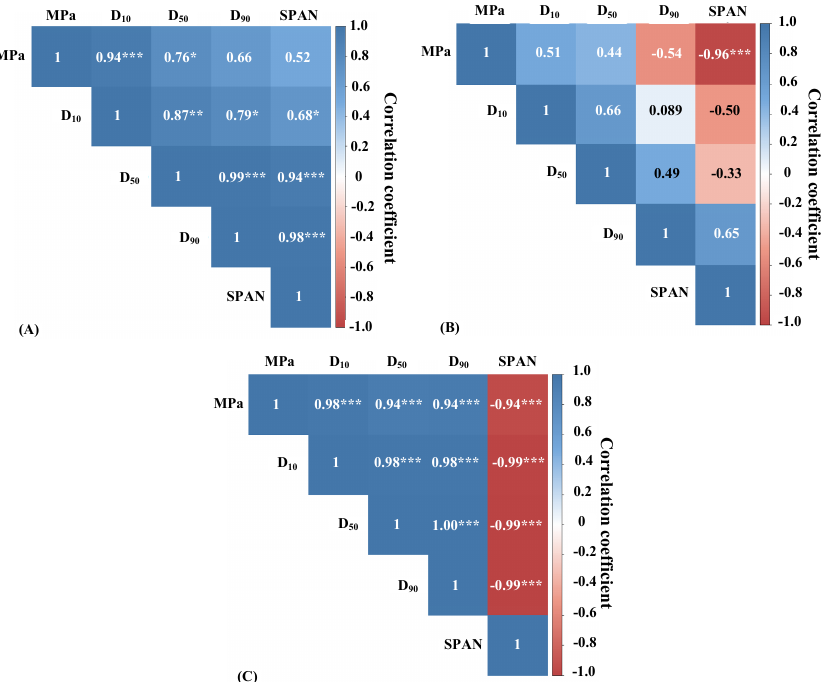
Figure 2. Pearson’s bivariate correlation analysis between particle size distribution values (D 10 , D 50 , D 90 , and span) and UHPH pressure level (MPa) for powders produced via CCSD ( A ), MXSD ( B ), and FD ( C ). Output numbers represent the correlation coe ffi cients. The starts represent the p -value of the correlations: * p < 0.05, ** p < 0.01, *** p <